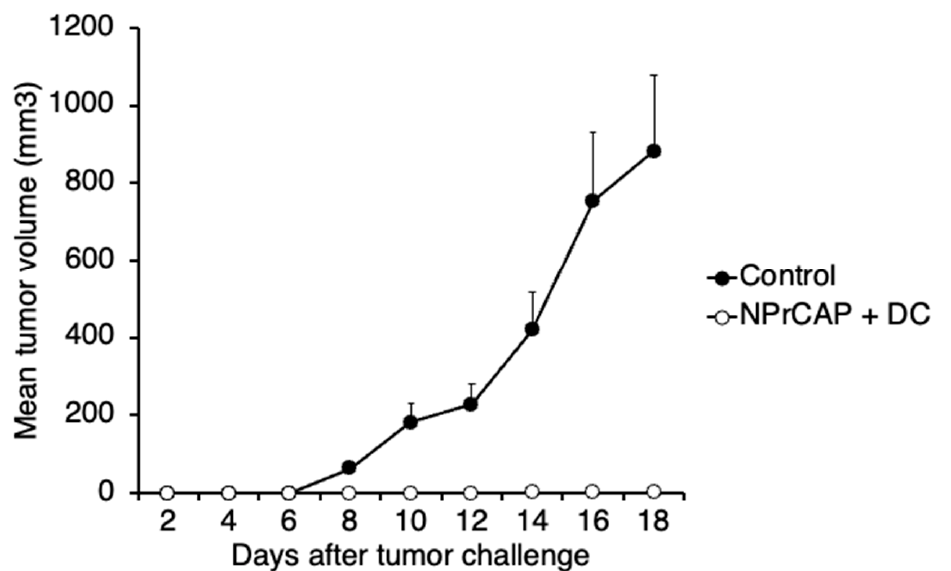
Figure 5. Growth inhibition of a secondary transplanted tumor in mice in the N -Pr-4- S -CAP and BMDCs treatment group. Mice that had been cured by N -Pr-4- S -CAP and BMDCs combination therapy were rechallenged with B16F1 melanoma, and tumor growth was compared to that in naïve mice transplanted with B16F1 melanoma.